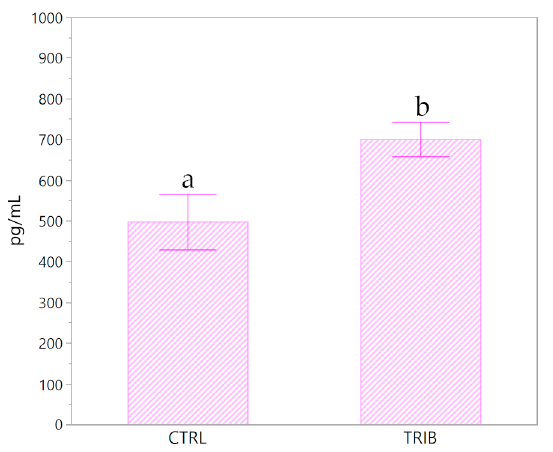
Figure 1. Serum insulin concentrations (pg / mL) in the control group (CTRL) and in the group of piglets fed a diet supplemented with 0.2 % tributyrin (TRIB). Data are presented as the mean a,b: significant di ff erences between groups ( p = 0.0187).